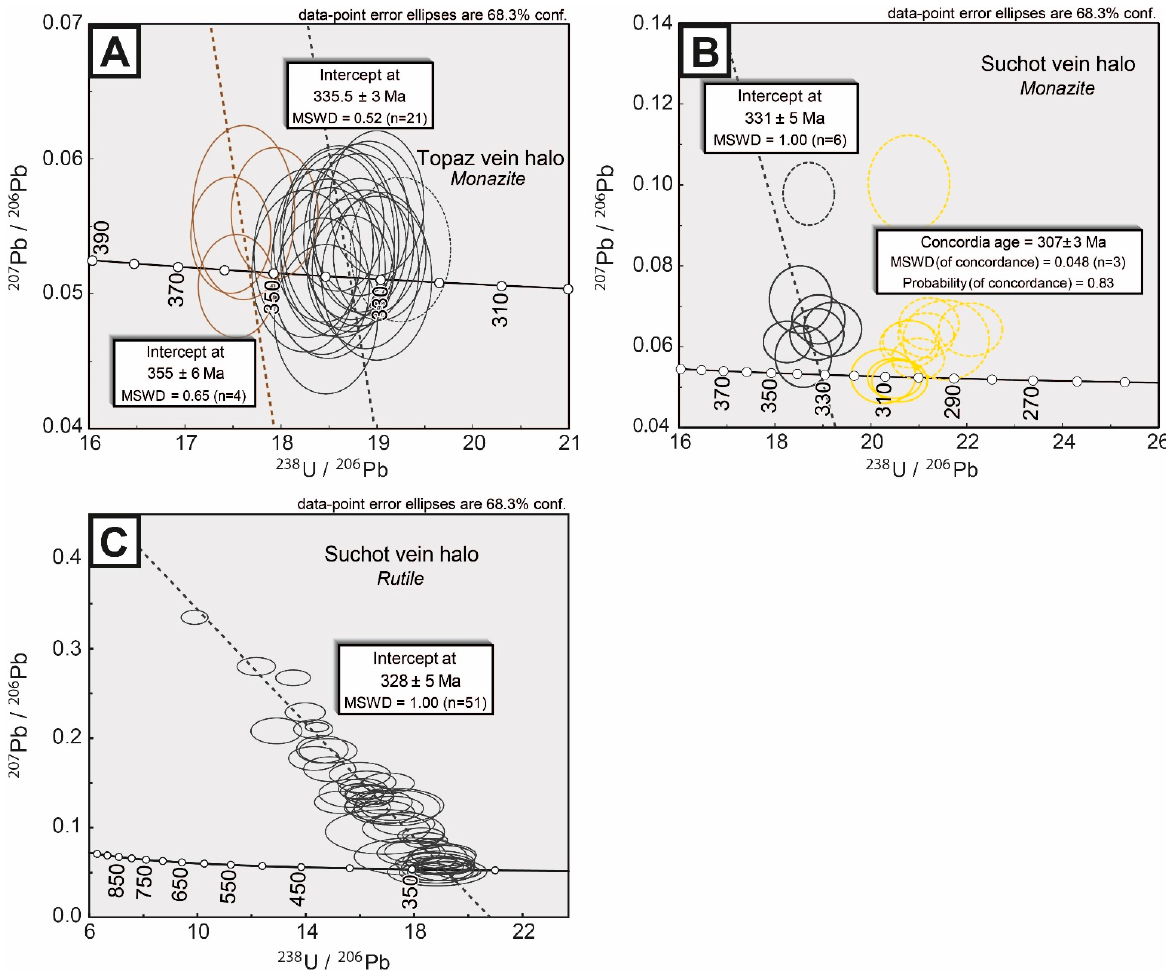
Figure 3. Terra Wasserburg diagram for monazite from topaz veins halos, and monazite and rutile from Suchot vein halo. MSWD: Mean Standard Weighed Deviation. ( A ) Monazite crystals from topaz vein halo. ( B ) Monazite crystals from Suchot vein halo. ( C ) Rutile crystals from Suchot vein halo.